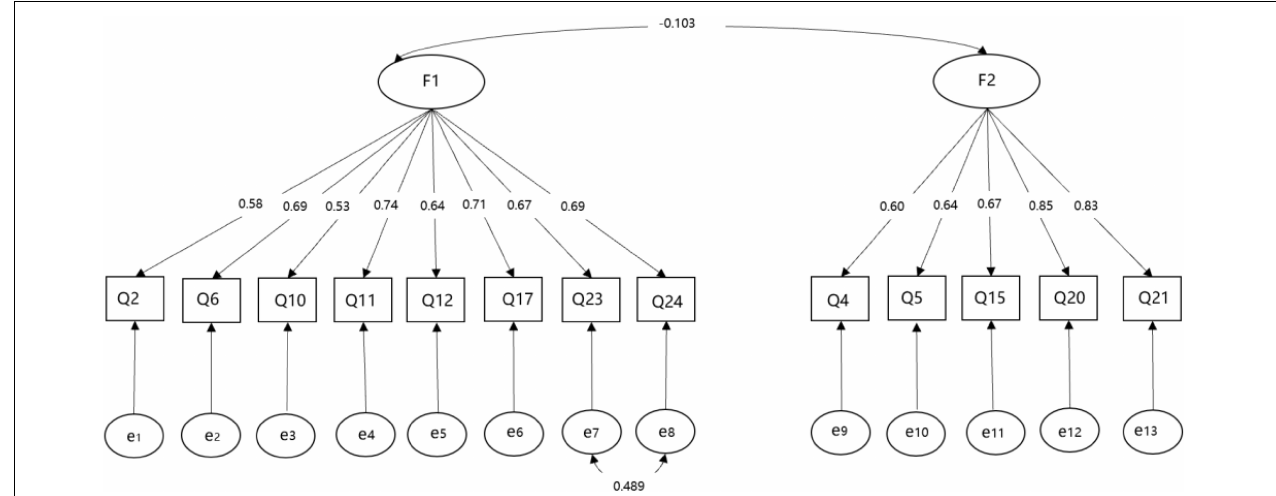
FIGURE 1 | Confirmatory factor analysis of ECEC teacher play beliefs.